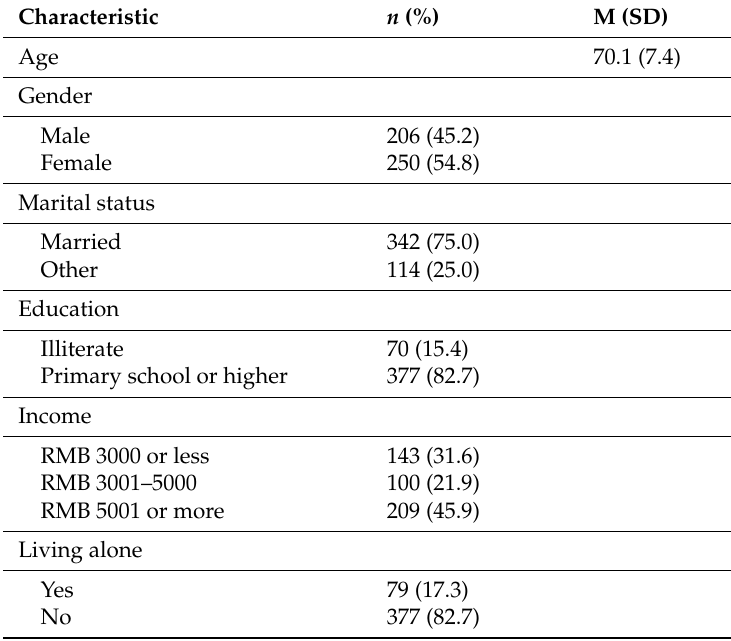
Table 1. Characteristics of the sample ( N =